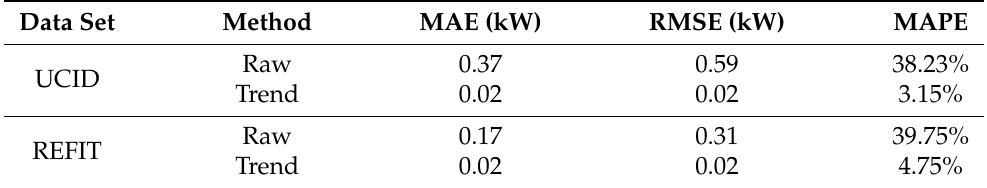
Table 6. Performance metrics obtained when applying our method on both the raw data as well as the trend component of the UCID and REFIT datasets to obtain twelve-step-ahead predictions. Data Set